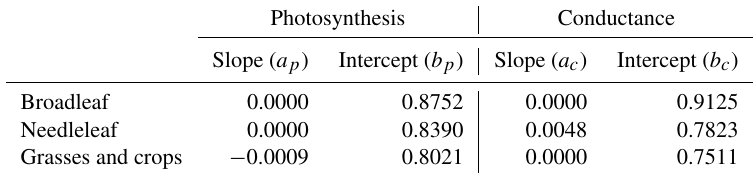
Table 1. Slopes (per mmolm − 2 ) and intercepts (unitless) used for O 3 damage factors in Eqs. (4) and (5), following Lombardozzi et al. (2015).